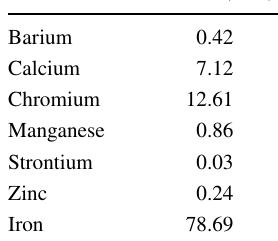
Table 2 Composition of di/ trivalant cations in the metal naphthenate